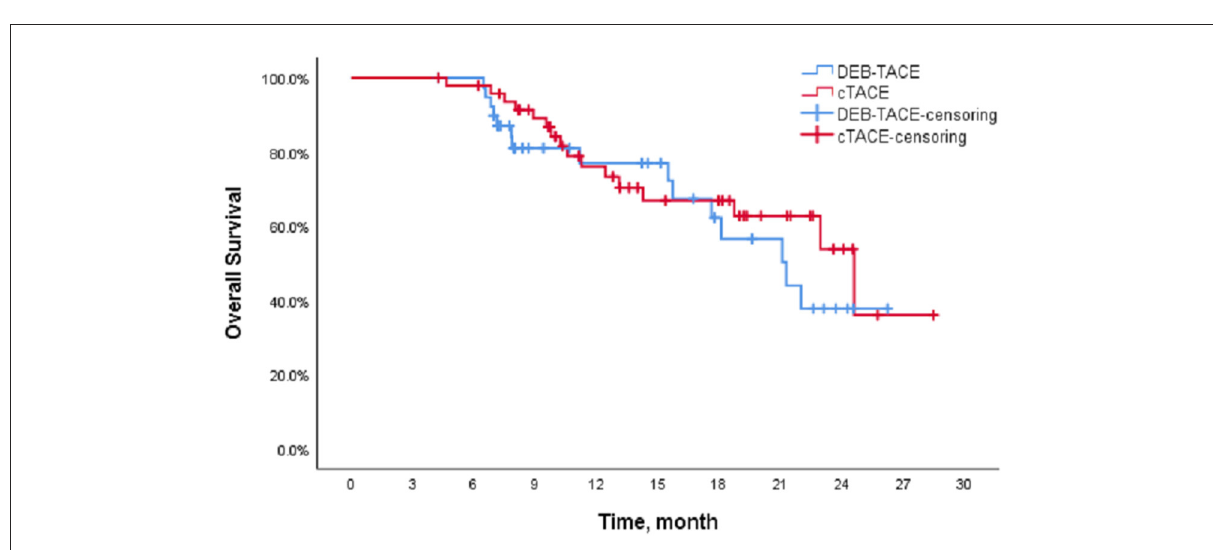
FIGURE2 Overall survival of the DEB-TACE and cTACE groups.